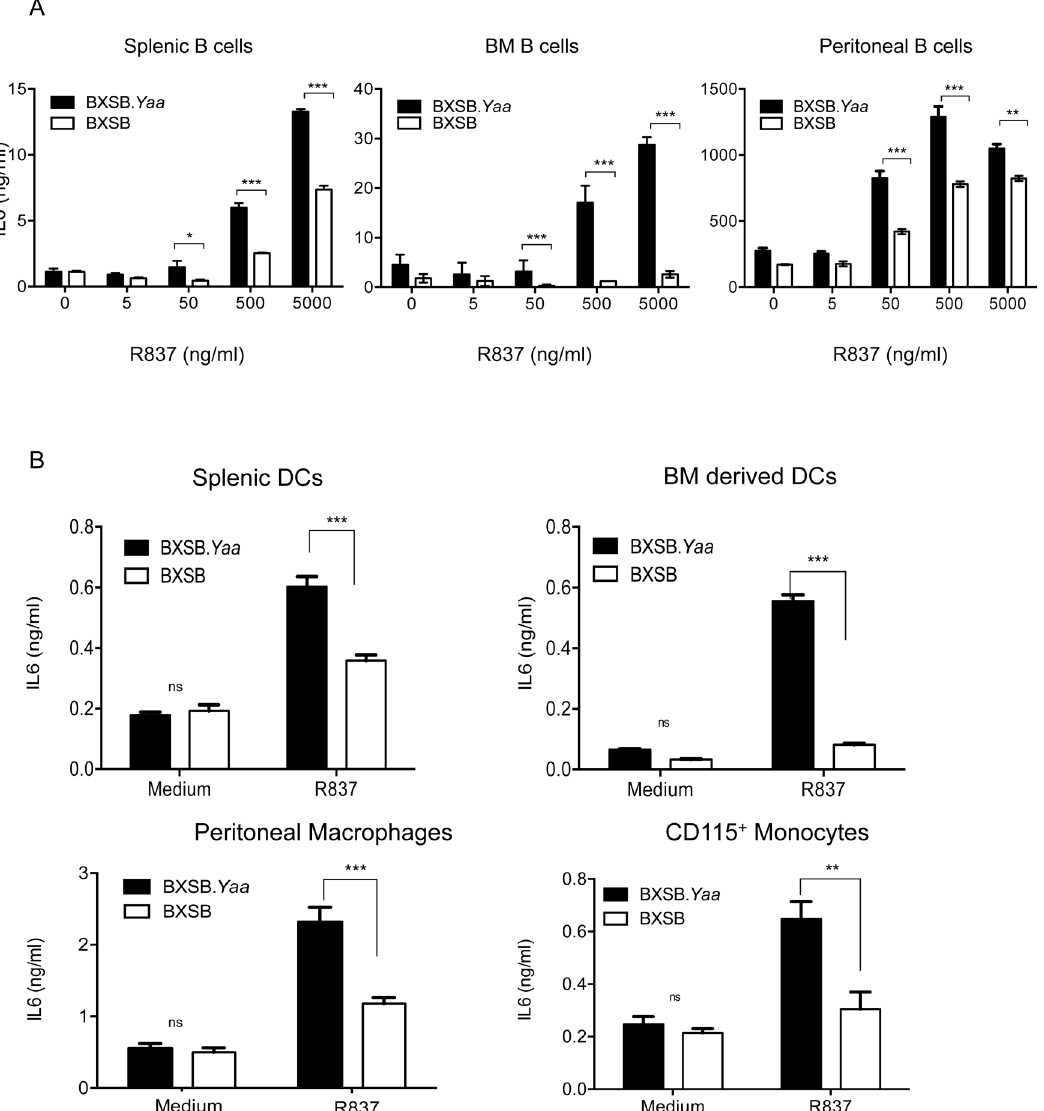
Fig 2. B cells from BXSB. Yaa mice are potent producers of IL6. (A) CD43 - B cells were purified from spleen, BM and peritoneal lavage of 4 – 5 month old BXSB. Yaa and BXSB mice and stimulated with graded concentrations of Imiquimod (R837). (B) Dendritic cells enriched from spleen (splenic DCs) or differentiated from BM precursors (GMCSF (40ng/ml) and IL4 (20ng/ml) for 9 d with media changed every third day), peritoneal macrophages and CD115 + monocytes from spleens of BXSB. Yaa and BXSB mice were stimulated with R837 (50ng/ml) in vitro . Supernatants were collected after 24 hours and IL6 levels were quantified using a standard sandwich ELISA. Data expressed as mean ± SEM of triplicate wells are representative of 4 – 6 independent experiments. p values are determined by two-way ANOVA. * p < 0.05, ** p < 0.01, *** p < 0.0001.